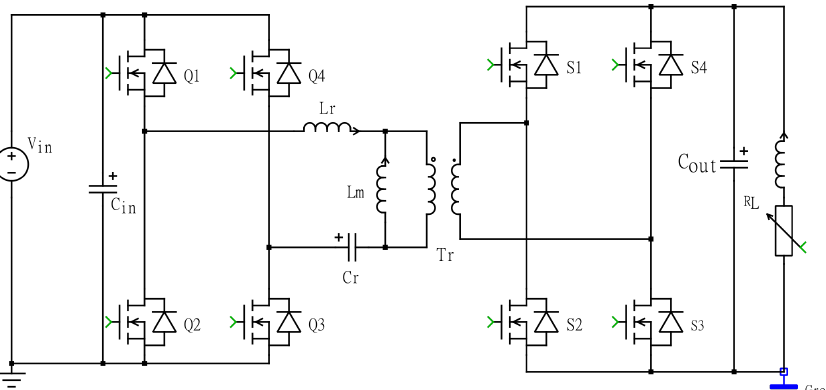
Figure 2. Full-bridge LLC converter